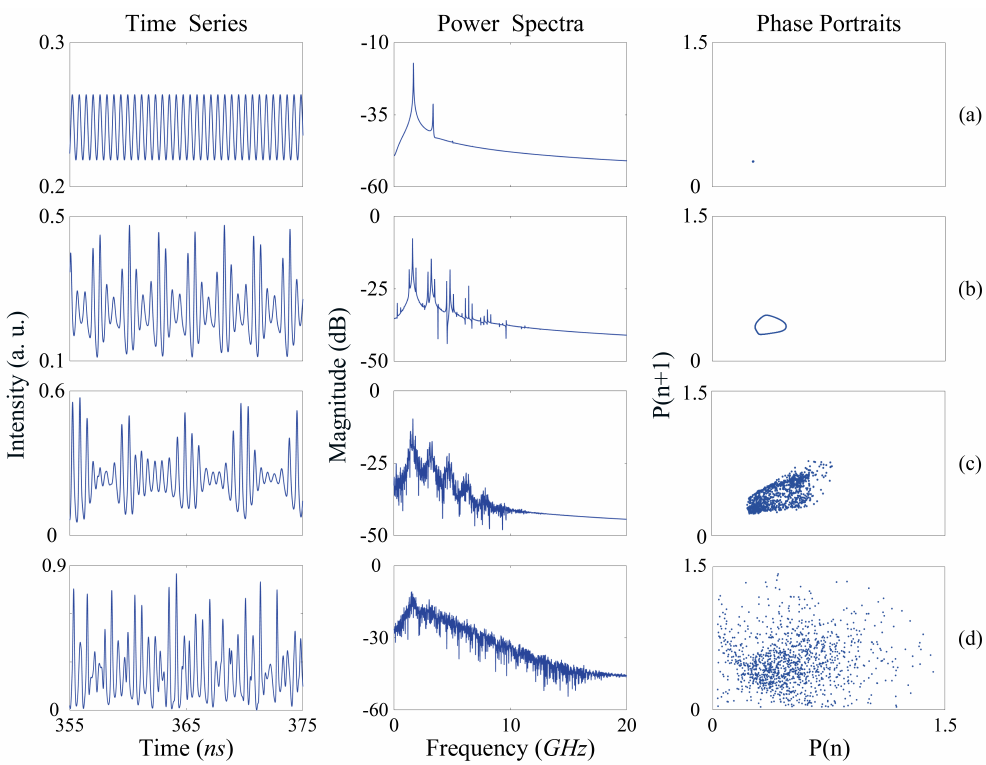
Figure 4. Numerically simulated time series, power spectra, and phase portraits of the proposed model in different dynamic states, where k = 1 ns − 1 and ( a ) τ = 1.6 ns ; ( b ) τ = 2.3 ns ; ( c ) τ = 4.6 ns ; ( d ) τ = 4.6 ns and k = 3.5 ns − 1